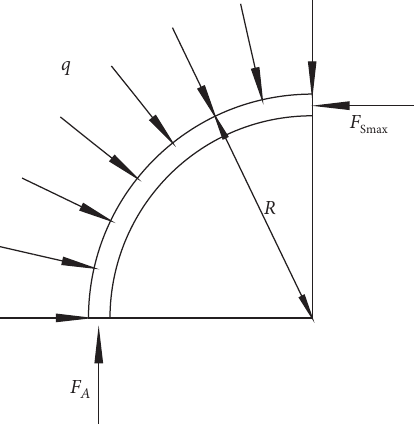
Figure 11: Maximum shear force of